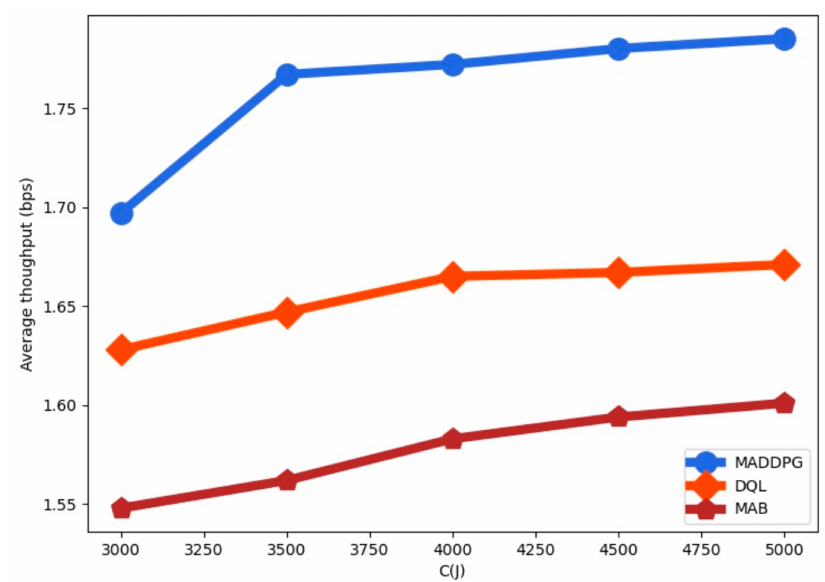
Figure 8. Average throughput as a function of the battery capacity C . The average throughput for the RL-algorithms is shown in Figure 9 as a function of the energy transfer efficiency between two UAVs β . We observe that the average throughput is increased with the energy transfer efficiency. The average throughput is higher for MADDPG than for DQL and for MAB for all the values of β .